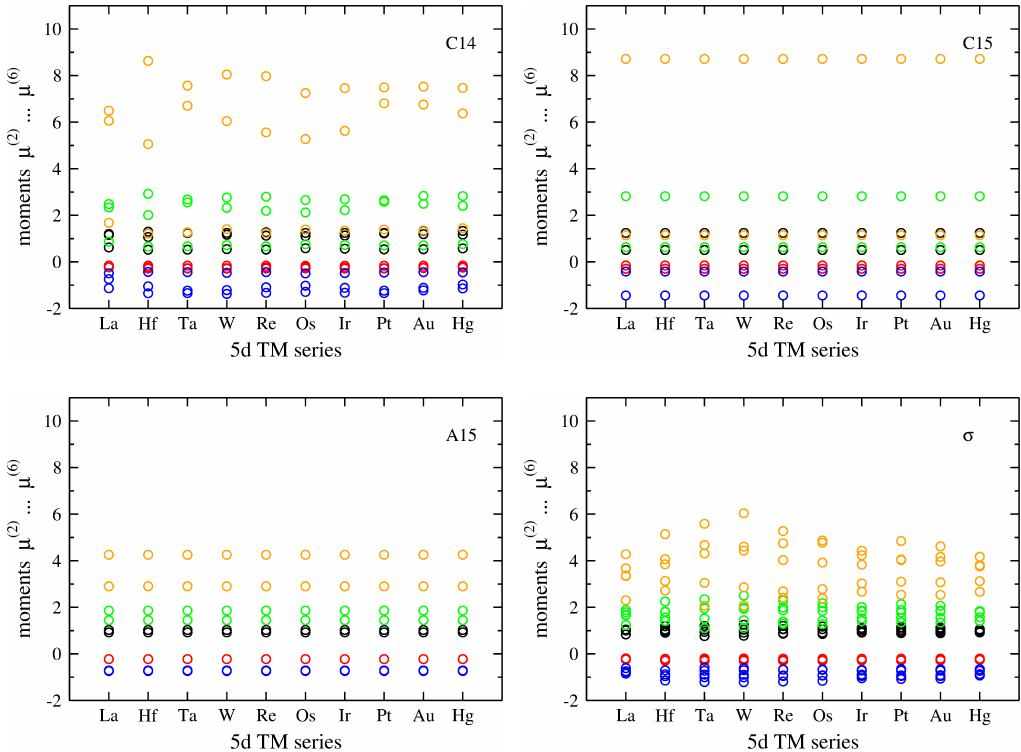
Figure 3. Trend of second to sixth moments of unary C14 ( top left ), C15 ( top right ), A15 ( bottom left ) and σ ( bottom right ) phases across the 5 d TM series. The values were computed from the DFT-relaxed unit cells and scaled such that (cid:104) µ ( 2 ) (cid:105) = 1. (for color coding, see Figure 2.)